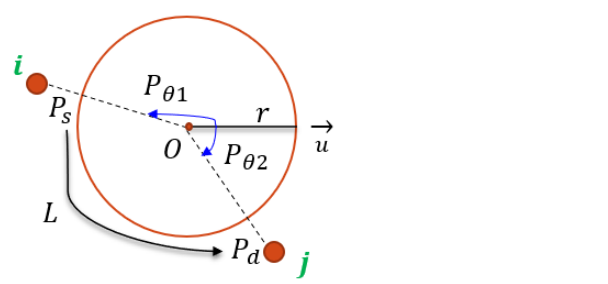
Figure 6. Graph representation for the ADC